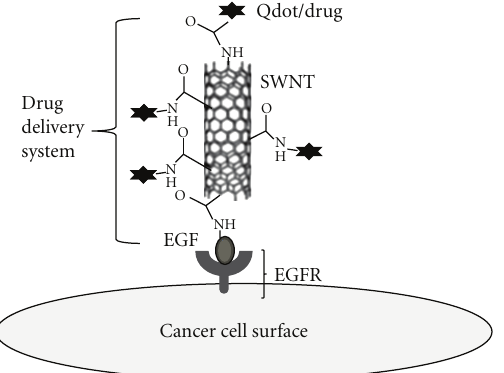
Figure 5: Nanotube-based drug deliver delivery/imaging system. Schematic showing nanotube bundles bioconjugated with EGF targeting the cell surface receptor EGFR on the cancer cell on one side and with quantum dot (for imaging) or drug molecule (for delivery) on other side. ( Modified figure ; original source : Bhirde et al ., ACS Nano , 2009 , doi : 10.1021/nn800551s ).